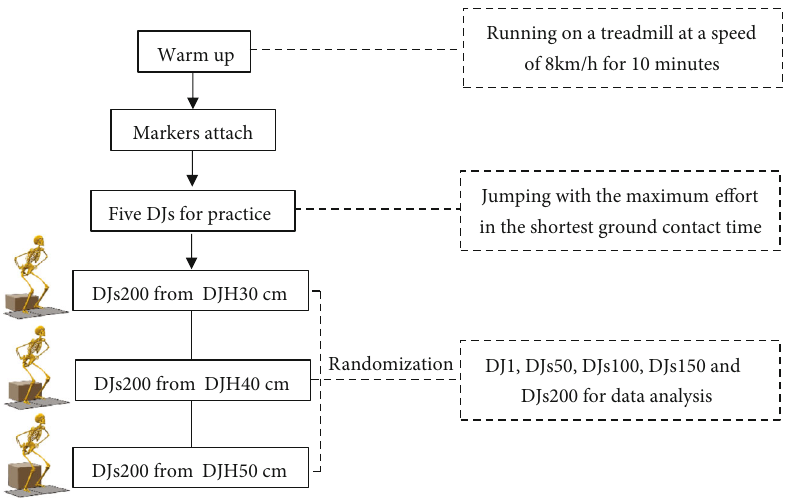
Figure 1: Framework for the proposed